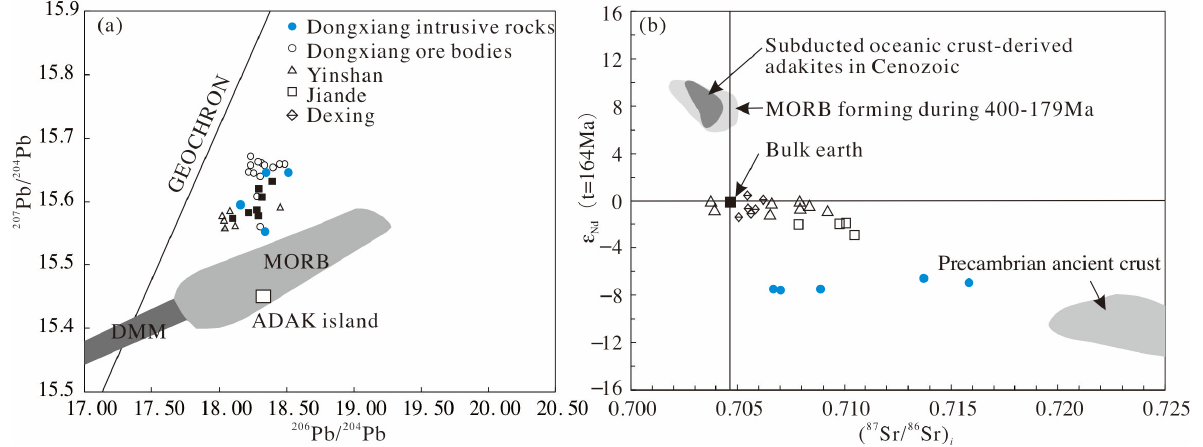
Figure 5. ( a ) 207 Pb/ 204 Pb vs. 206 Pb/ 204 Pb diagram and ( b ) ε Nd (t) vs. ( 87 Sr/ 86 Sr) i diagram (data from Cai,